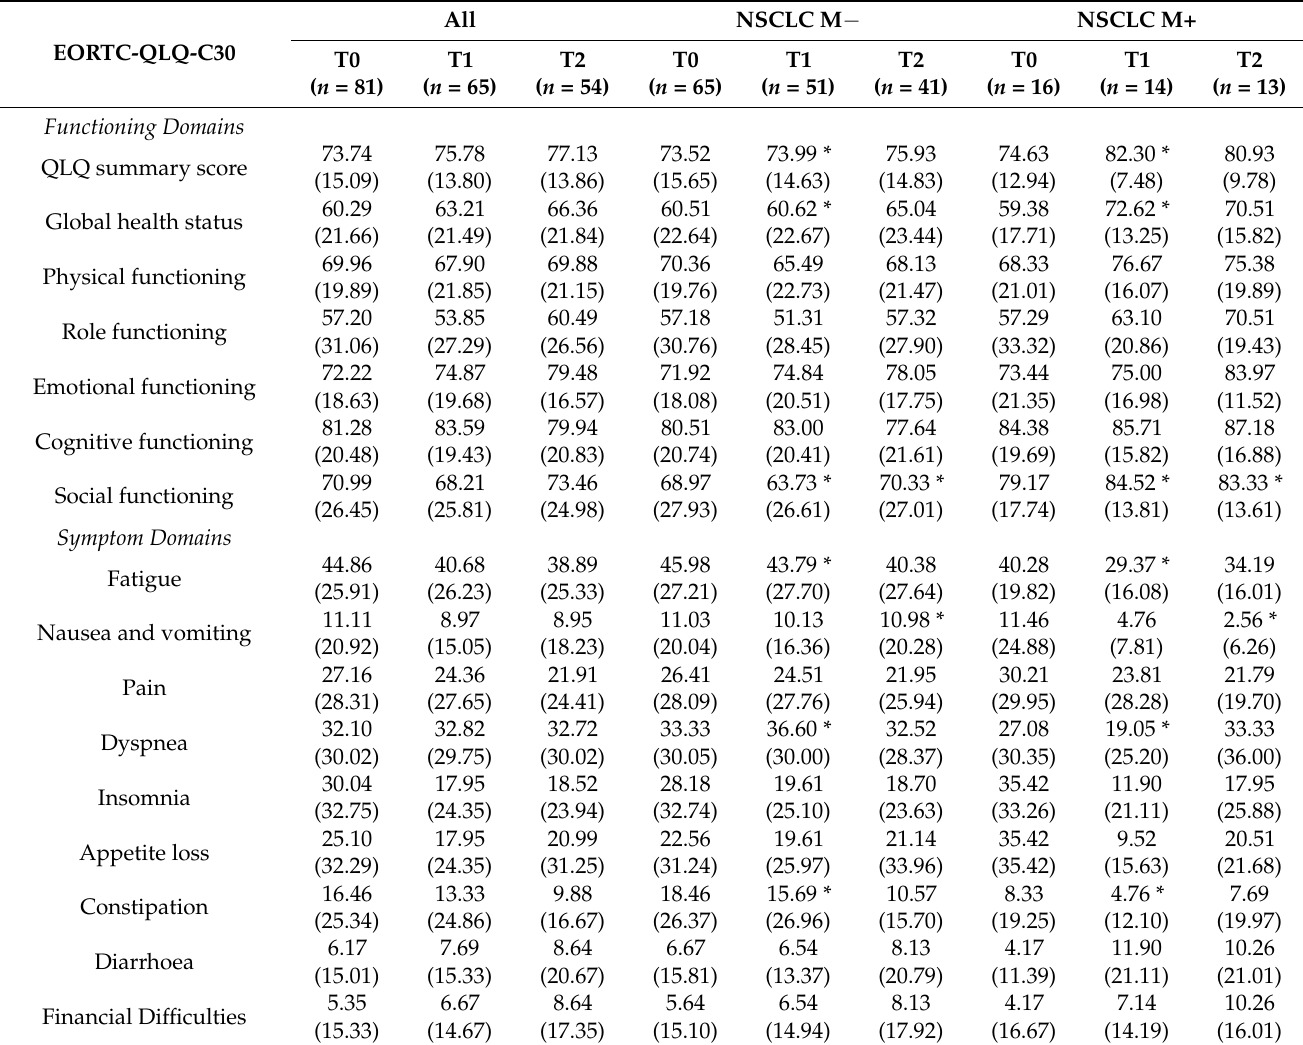
Table 2. Mean Health-Related Quality of Life